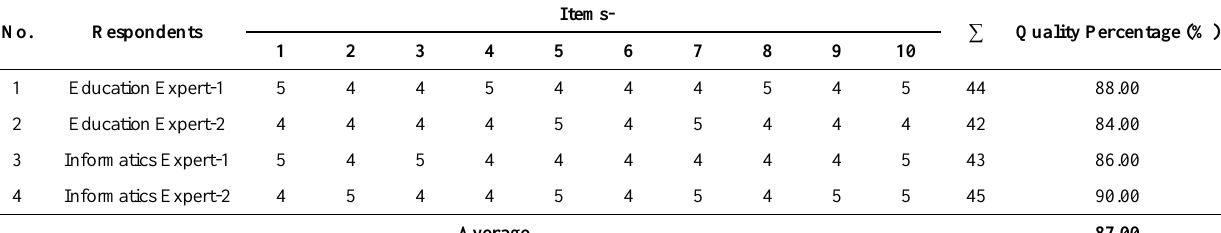
Table 5. Initial trial results toward the design of the Tat Twam Asi - Discrepancy evaluation model based on TOPSIS.